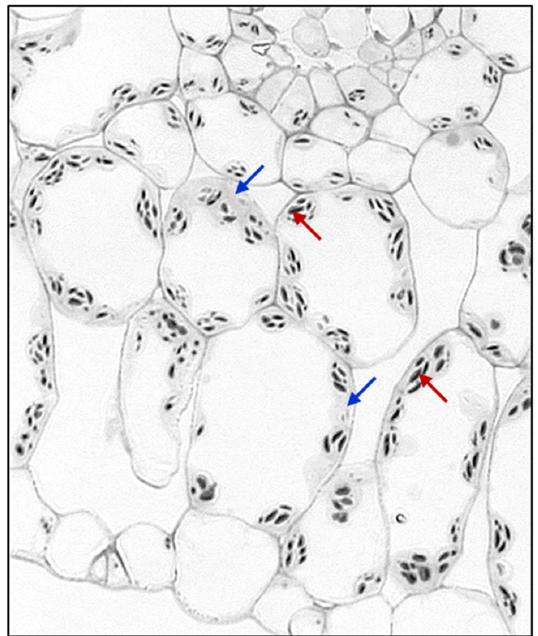
Figure 1. Light micrograph of starch granules in chloroplasts of arabidopsis ( Arabidopsis thaliana ) mesophyll cells harvested at the end of the day. Protein dense chloroplasts (the light-greyregions) and starch granules (the black regions) are indicated with a blue and a red arrows, respectively. Details are described in Supplemental Methods.